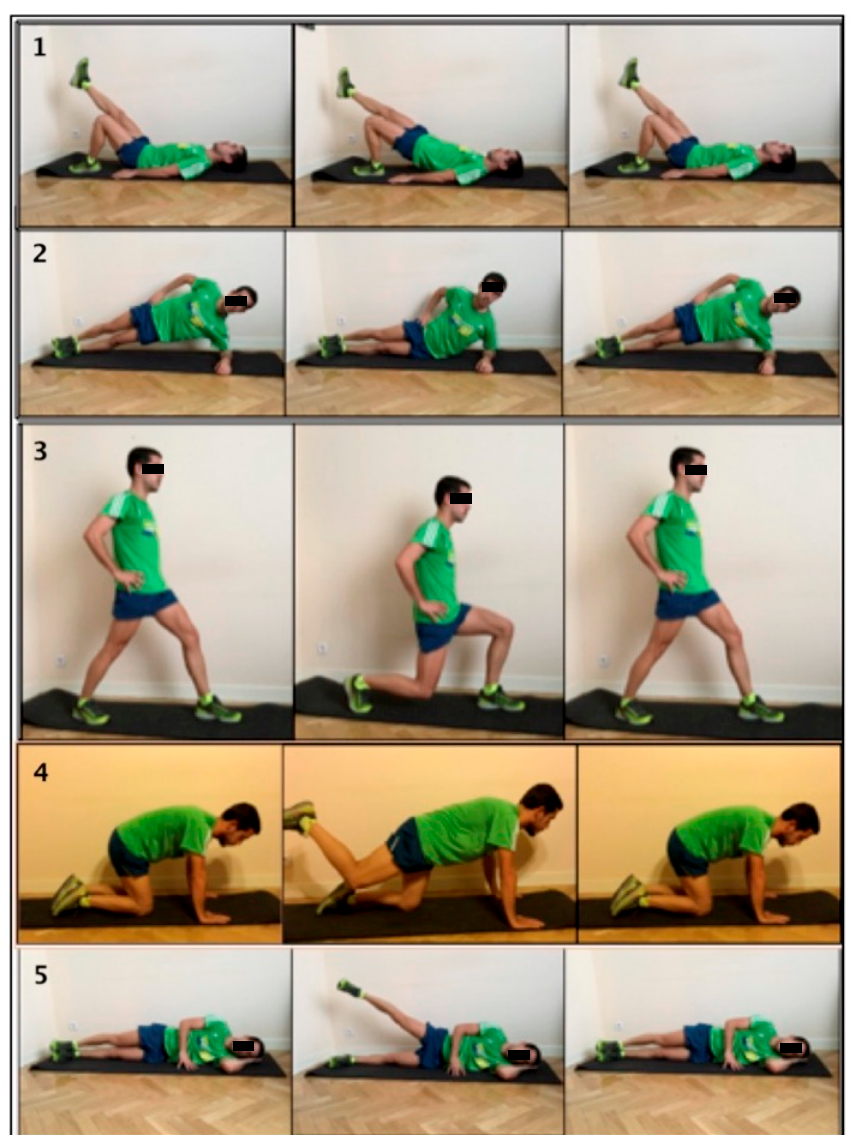
Figure 3. Gluteal strengthening exercises: ( 1 ) Shoulder bridge with elevation to one leg: make sure the bent knee does not turn medial or laterally; do not drop the contralateral hemipelvis either. ( 2 ) Lateral plank with two supports. ( 3 ) Lunge: forward knee must not be pushed out farther than the big toe. ( 4 ) Quadrupeia with three supports and knee bent: slight pelvic retroversion to inhibit erector muscles. ( 5 ) One leg elevation with trunk resting on the floor.